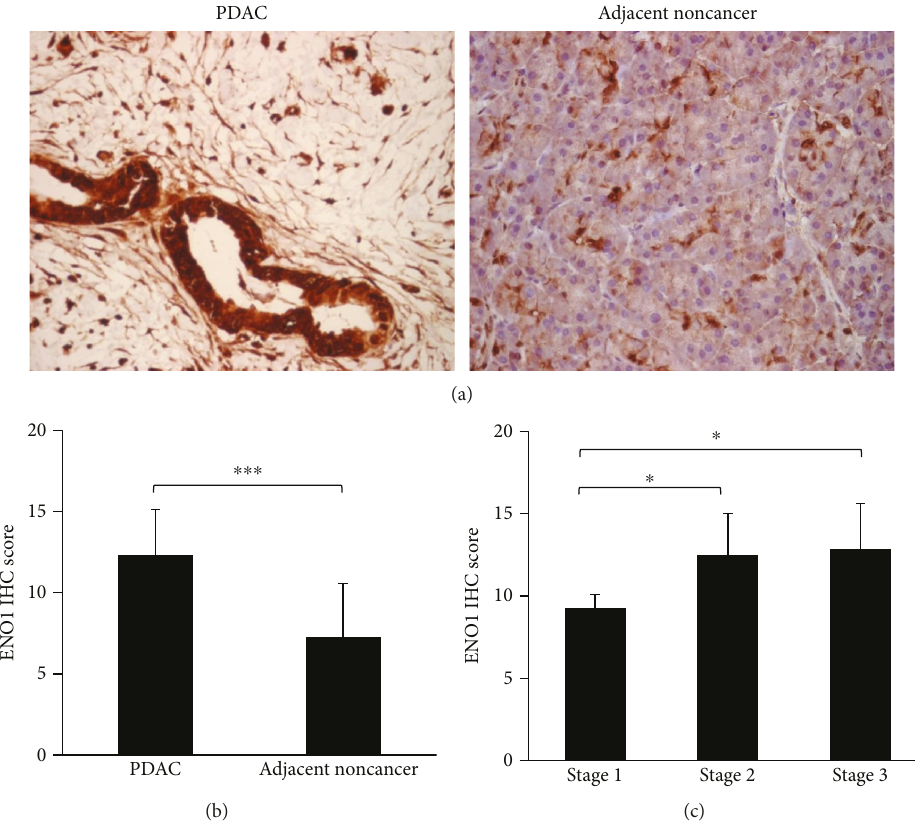
Figure 1: The expression of ENO1 in human PDAC and adjacent noncancer tissues. (a) Representative images showing IHC staining of ENO1 protein in human PDAC and adjacent noncancer tissues. Brown staining indicated ENO1 expression. Immunoreactivity level of ENO1 was higher in the nucleus and cytoplasm but weaker on the membrane. (b) Bar plots represented IHC score for ENO1 expression in human PDAC and adjacent noncancer tissues ( n = 31 ). (c) Bar plots represented IHC score for ENO1 expression in human PDAC tissues of stage I ( n = 4 ), stage II ( n = 4 ), and stage III ( n = 23 ). ∗ P < 0 05 , ∗∗∗ P < 0 001